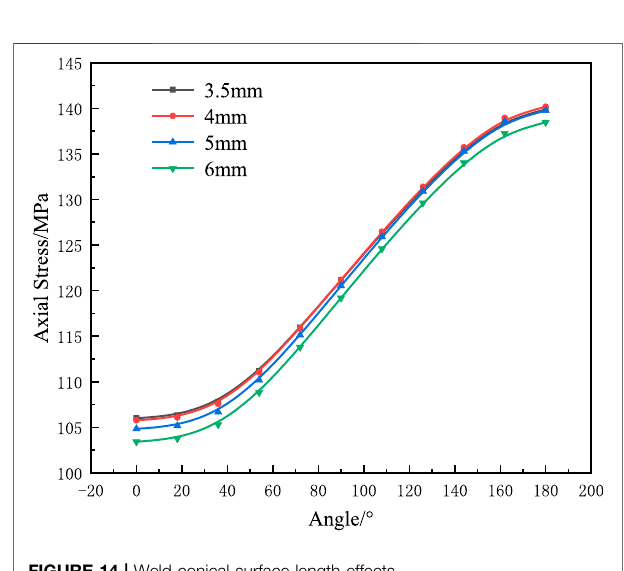
FIGURE 14 | Weld conical surface length